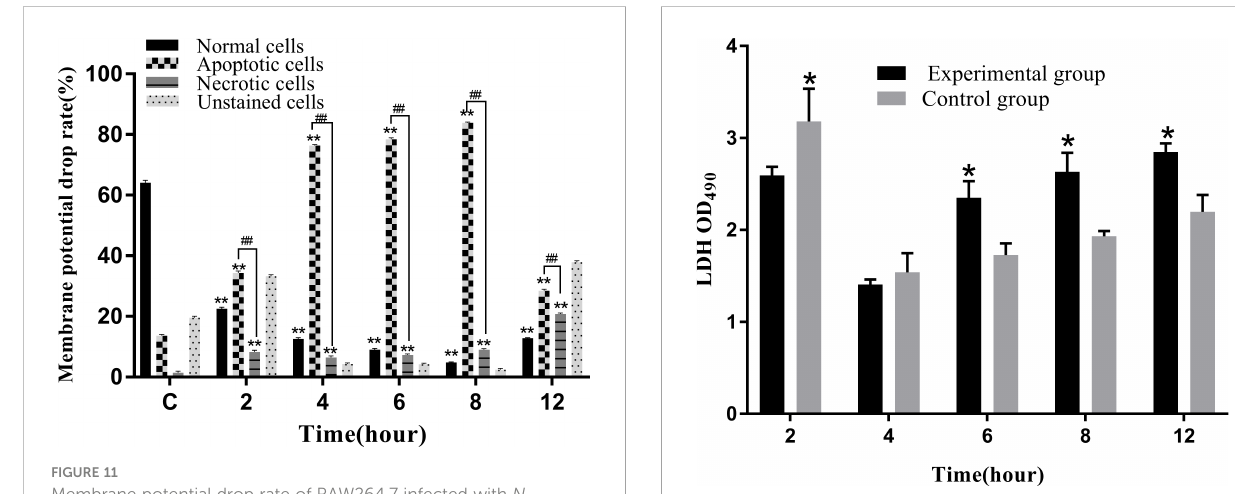
FIGURE 13 Levels of LDH release at different time periods. The LDH release assay was repeated three times, and each experiment was performed in triplicate. Results are presented as mean ± SD. * P <0.05, compared with the control group.